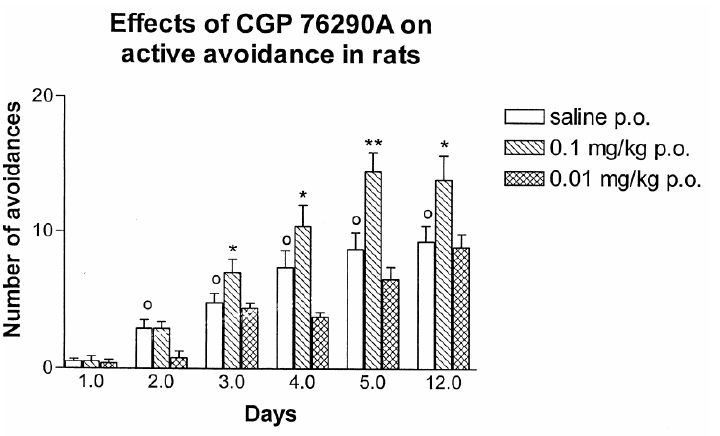
Fig. 3 Effects of the GABA B receptor antagonist CGP76290 on learning and memory processes in active avoidance test.